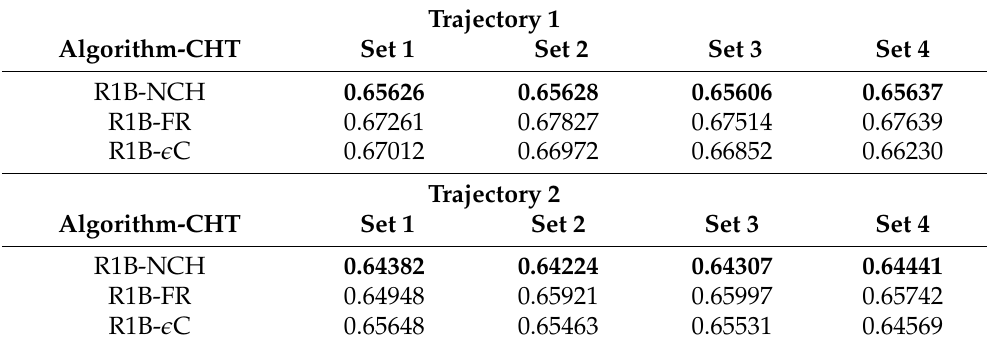
Table 14. Minimum value of the objective function through different sets of thirty algorithms’ executions in study case 2 in both